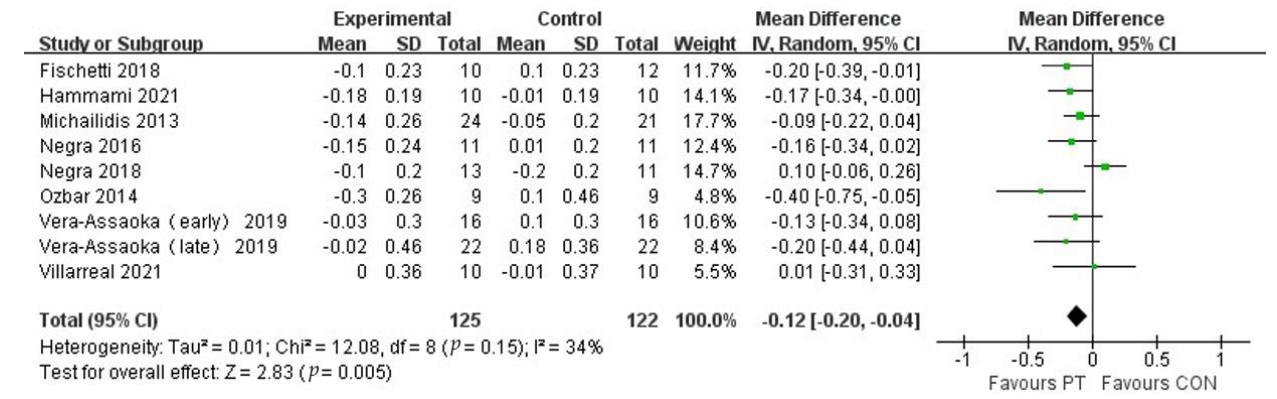
Figure 8. Forest plot of 20-m sprint of experimental and control groups.